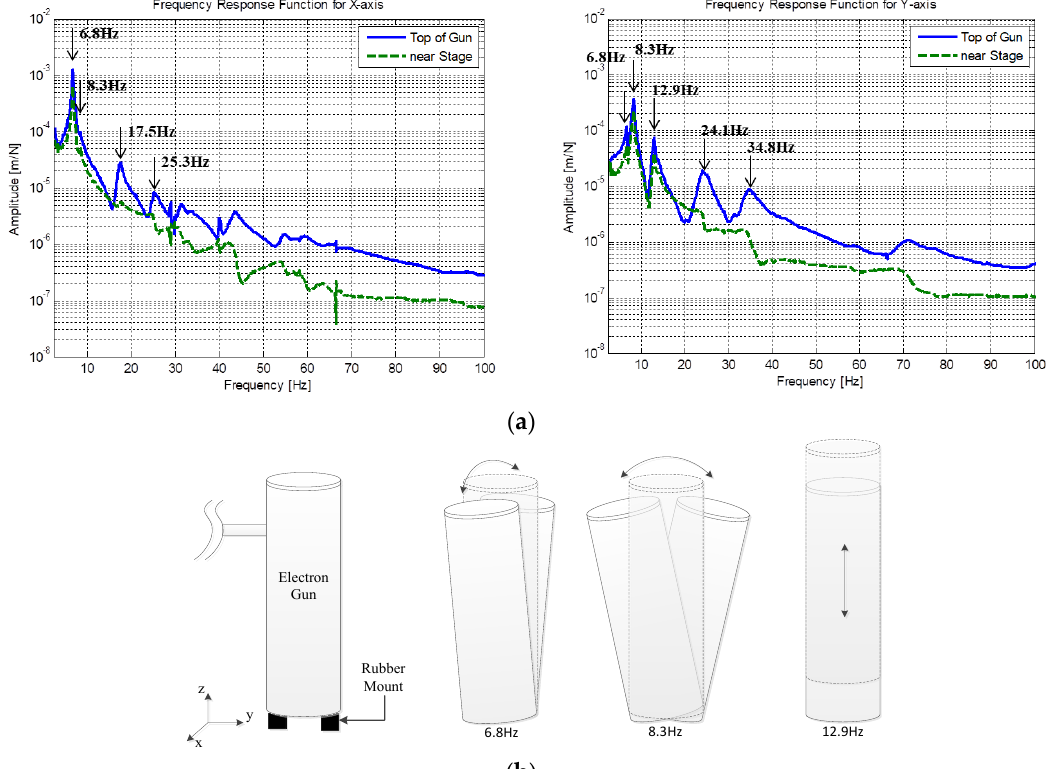
Figure 4. Vibration measurement under the normal operational condition. ( a ) Frequency response function; ( b ) Rigid body mode shapes of the electron gun.